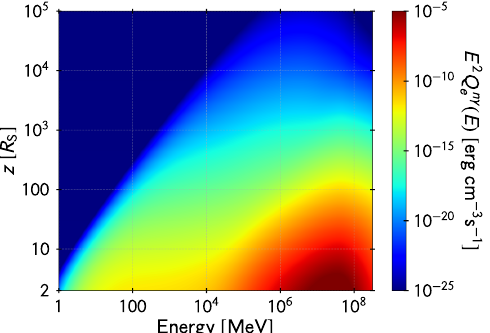
Figure 9. Electron injection in the jet axis via the Bethe-Heitler channel by photohadronic collisions of protons in the funnel. The vertical axis is the distance to the hole in units of Schwarzschild radii and the horizontal axis is the energy of the created electron. The color map represents the energy density injected in electrons per unit logarithmic bin of electron energy per unit